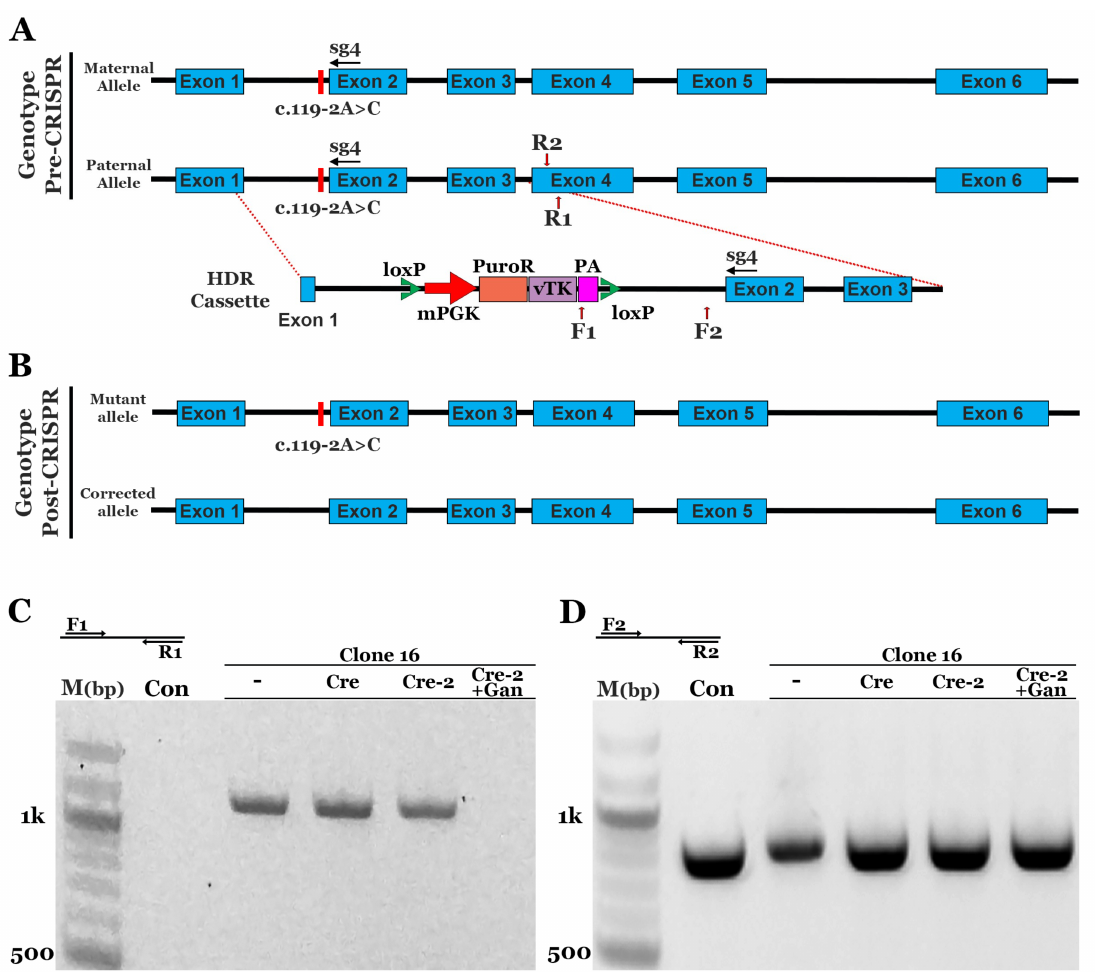
Figure 2. CRISPR-based homology-directed repair of the c.119-2A>C mutation in patient-derived iPSCs. ( A ): Schematic diagram depicting the genotype pre-CRISPR correction and the homology-directed repair (HDR) cassette designed to repair the c.119-2A>C mutation: Homologous sequence